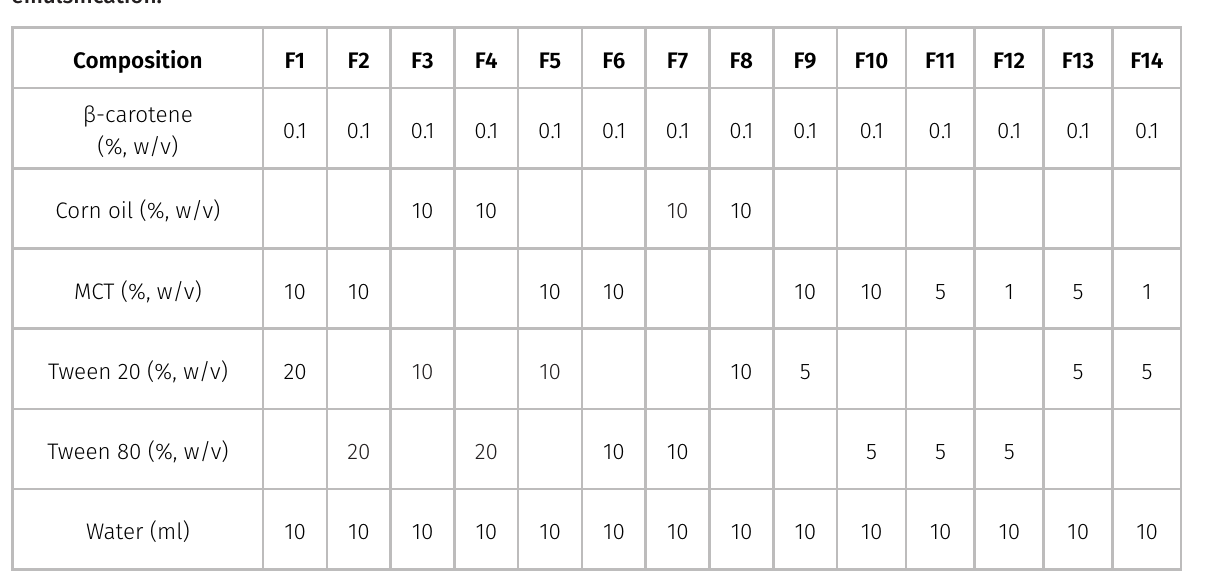
Table I. Composition of the formulations studied for obtaining nanoparticles with β-carotene by spontaneous